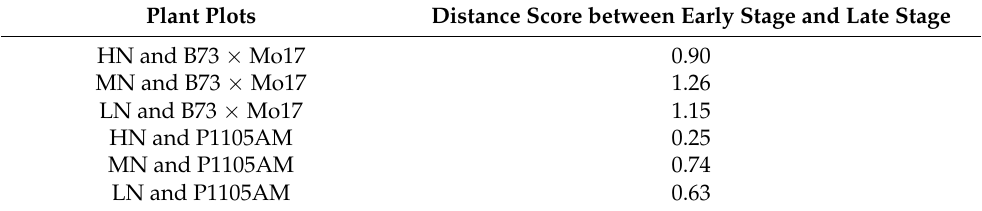
Table 5. The DTW distance scores between NDVI’s RDR curves of the plant plots with different plant stages. Plant